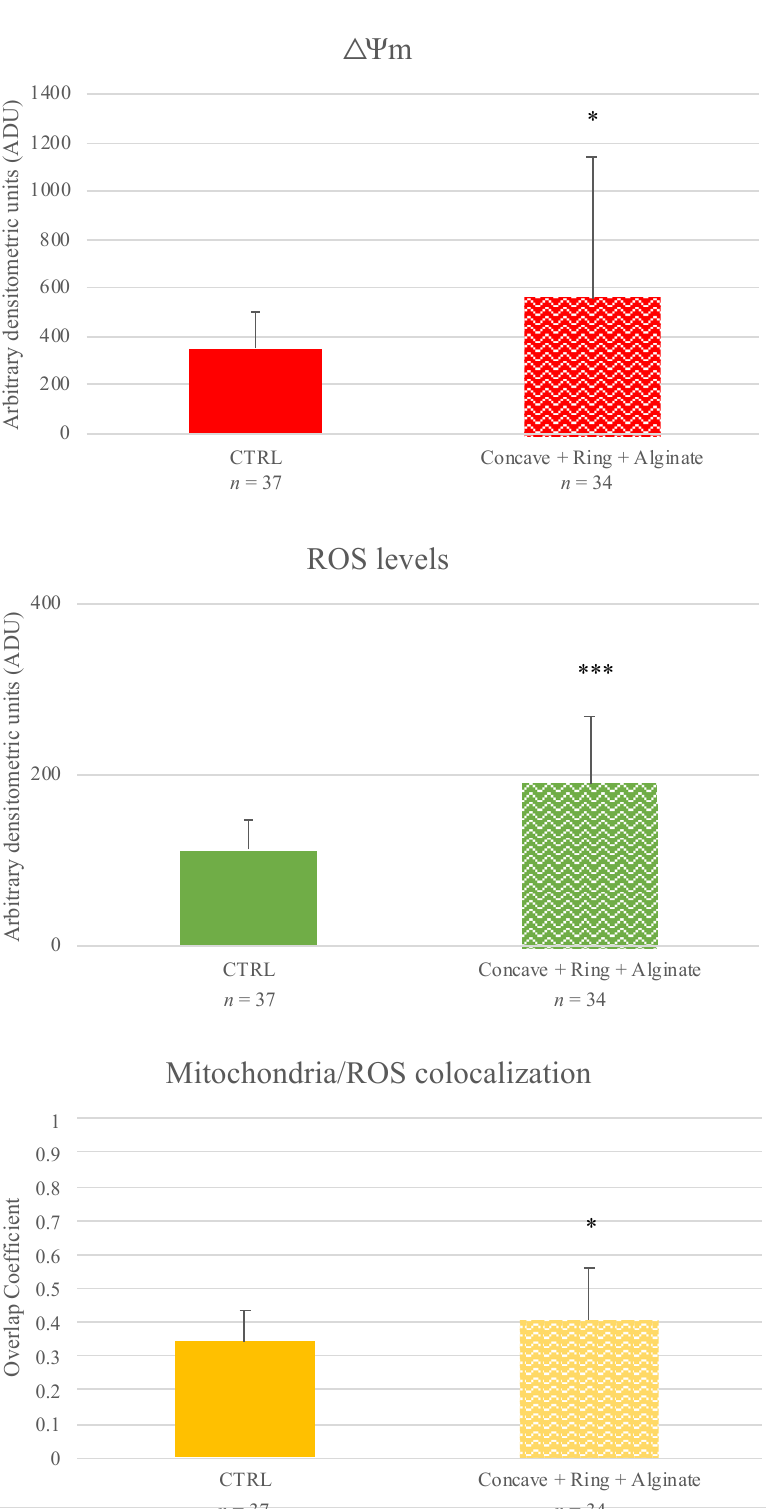
Figure 5. Effects of mIVM in alginate-filled supports on MII sheep oocyte mitochondria activity, intracellular ROS levels, and mitochondria/ROS colocalization. Numbers of analyzed matured oocytes are indicated at the bottom of each graph bar. Student’s t -test: * p < 0.05; *** p < 0.001 .